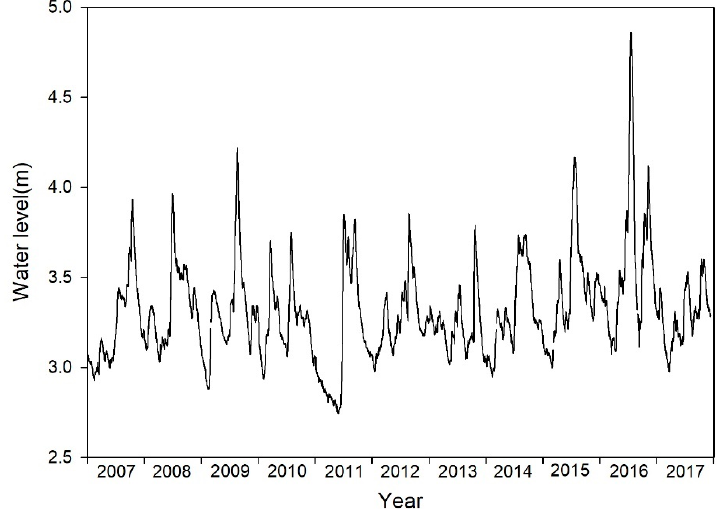
Figure 2. Variation in daily water levels of Lake Taihu from 2013 to 2017.